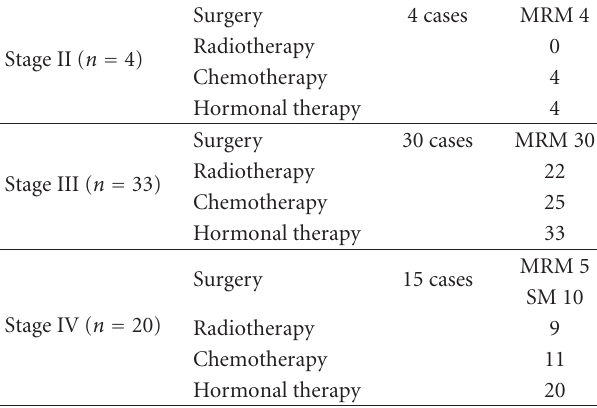
Table 2: Tumor characteristics in male patients with breast cancer. Characteristics